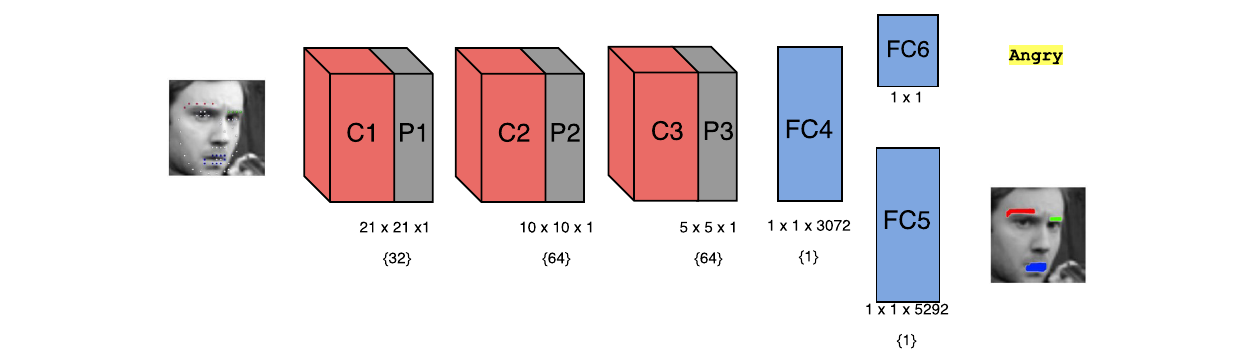
FIGURE 7 | The facial expression recognition system of Devries et al. (2014) that utilizes facial landmark (shown overlaid on the face toward the right of the image) recognition as an auxiliary task that helps improve performance on the main task of expression recognition.